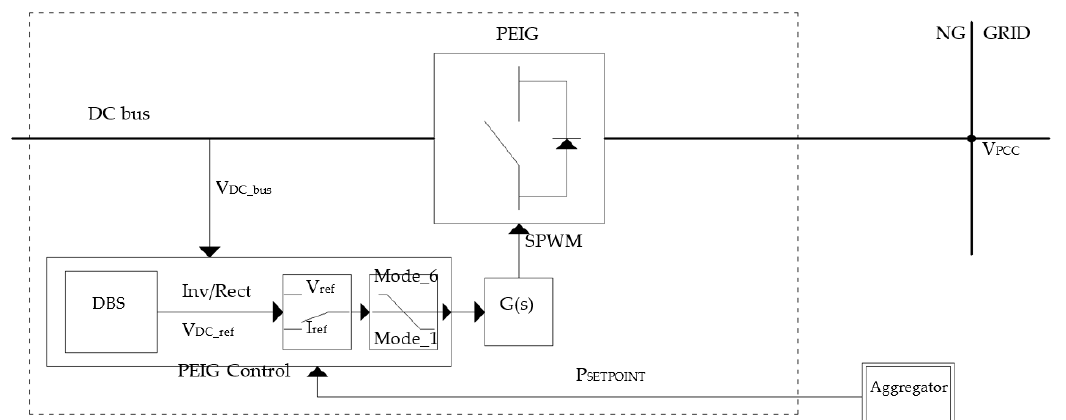
Figure 6. Power control scheme of PEIG.